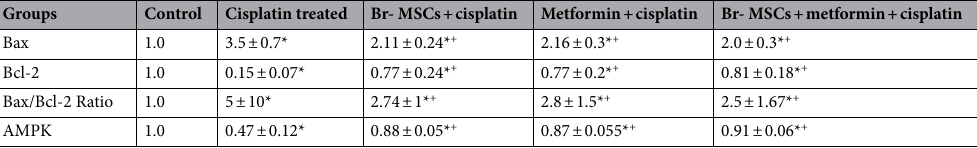
Table 3. Effect of Br-MSCs, metformin, and their combination on the cardiac pro-apoptotic BAX gene; anti-apoptotic Bcl-2 and AMPK in adult male albino rats with cisplatin-induced cardiotoxicity. Statistical analysis was done by using one way ANOVA test. Values were expressed as (mean ± SD). Br‑MSC Breast Milk mesenchymal stem cells. *P < 0.05 when compared with control. + P < 0.05 when compared with